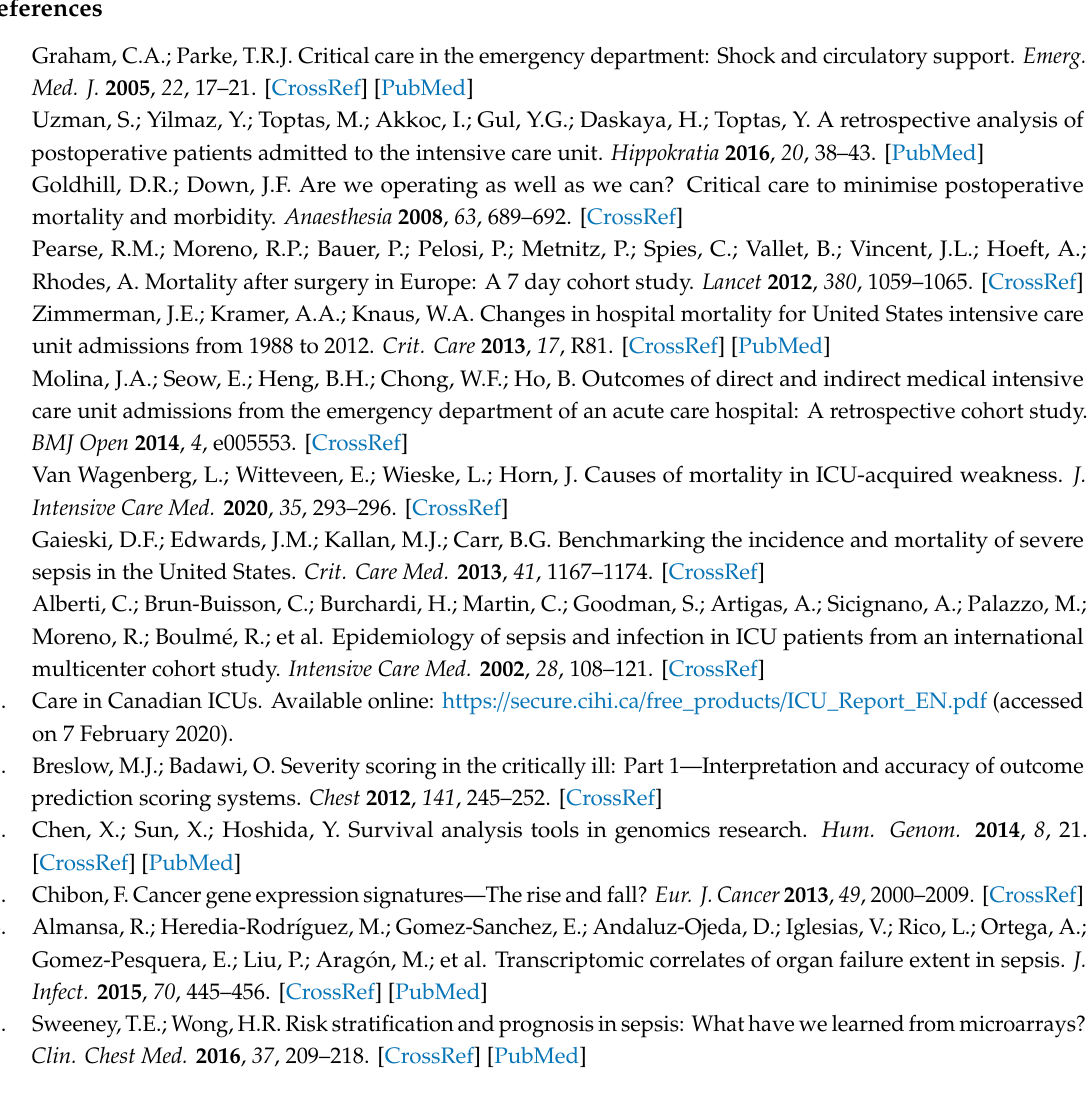
Table S1: Microarray